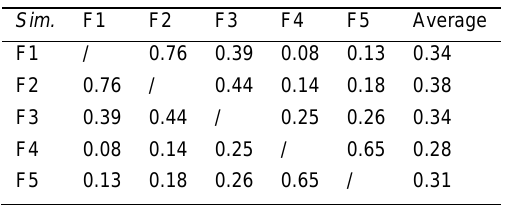
Table 1. Example of template